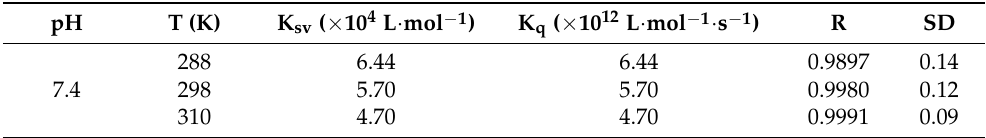
Table 1. Stern-Volmer quenching constants for the interaction of astilbin with HSA.